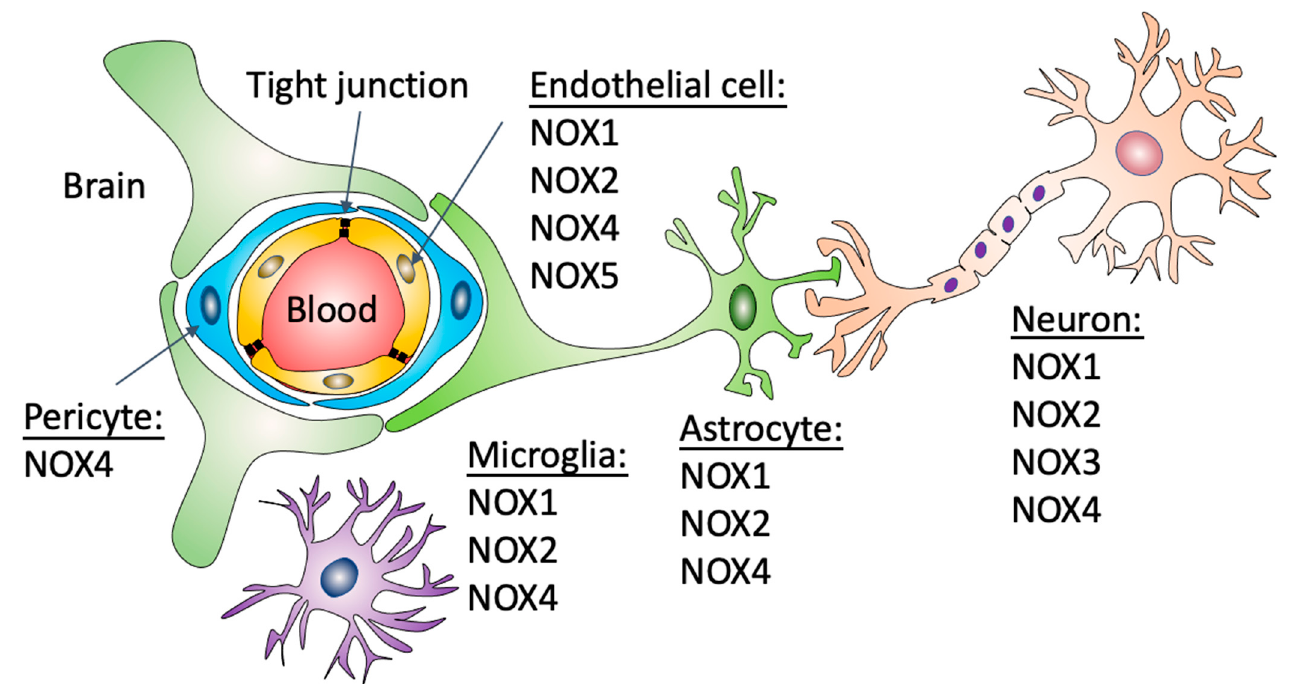
Figure 1. Expression of NADPH oxidases in different cell types that form the BBB. The BBB is formed by capillary brain endothelial cells surrounded by basal lamina, pericytes and astrocytic perivascular endfeet. Brain capillaries are also surrounded by microglial cells and neuronal processes. Nox1 and 2 have been described in endothelial cells, astrocytes, neurons and microglial cells. Nox4 has been described in endothelial cells, astrocytes, neurons, microglial cells and pericytes. Nox3, in contrast, has only been described in neurons and Nox5 in brain endothelial cells. A link between Nox1 activation and neuroinflammation has also been demonstrated.